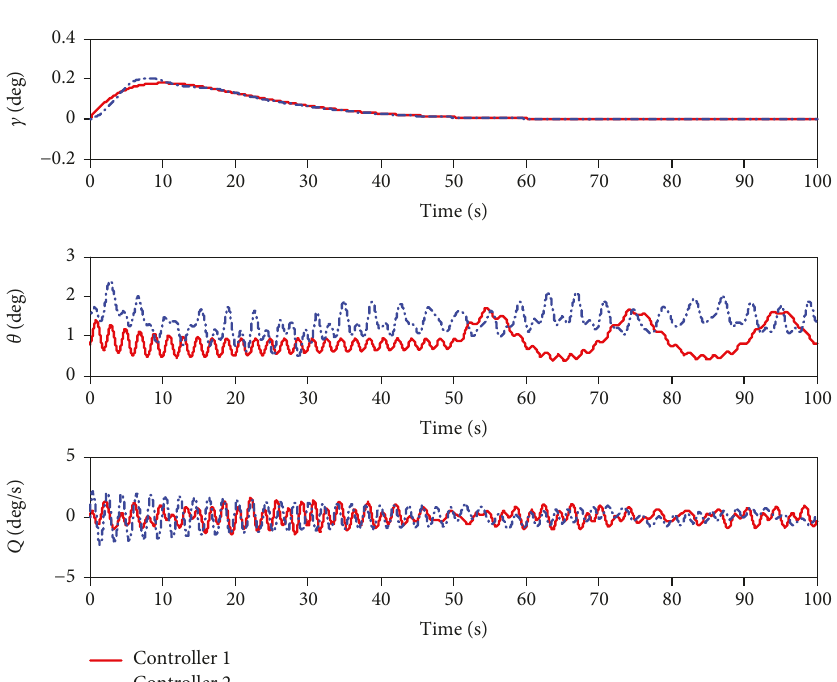
Figure 9: Velocity tracking performance.